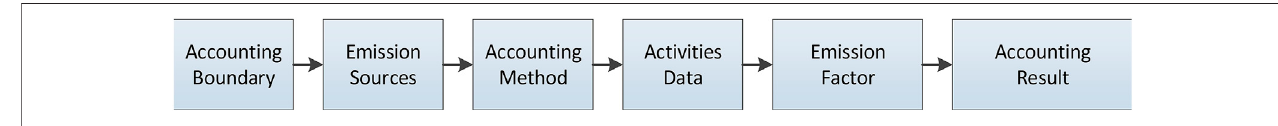
FIGURE 1 | Steps of carbon emission calculation.